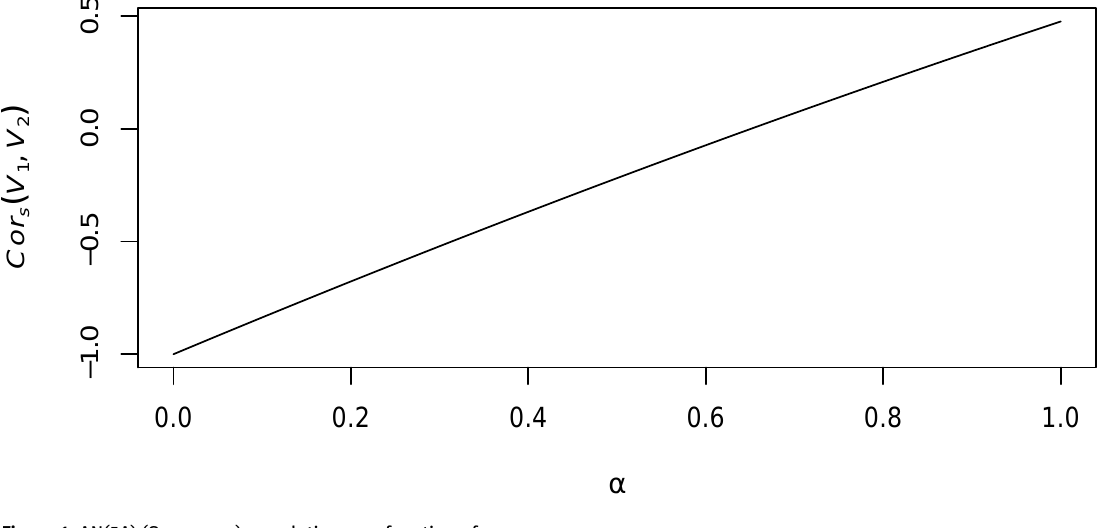
Figure 1: AN(5A) (Spearman) correlation as a function of α .